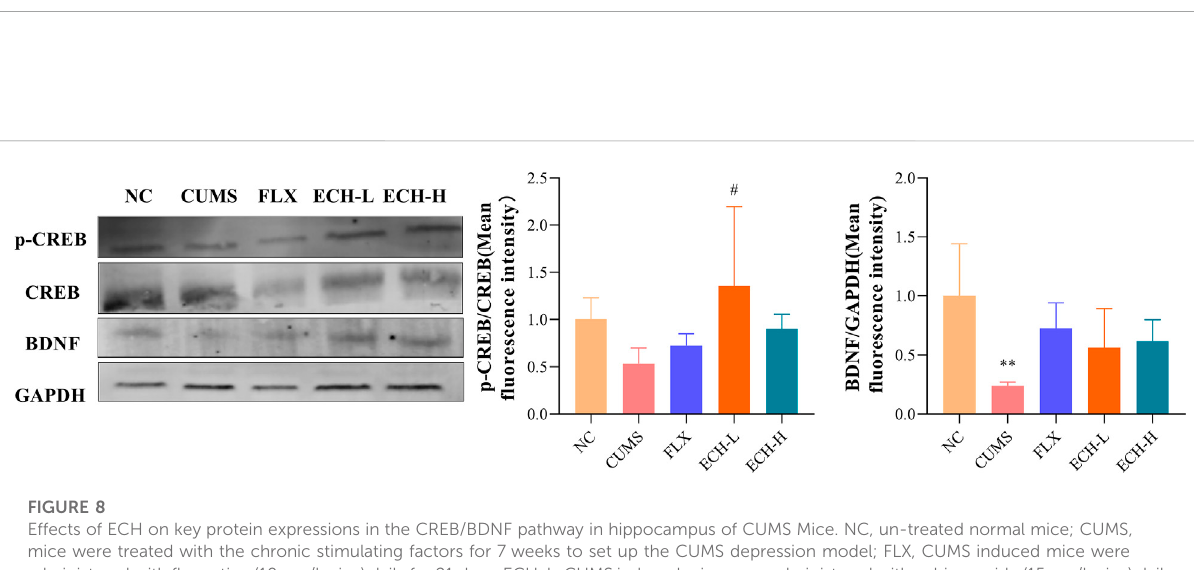
Effects of ECH on p-JAK1/JAK1 and p-STAT3/STAT3 levels in the hippocampus of CUMS Mice. NC, un-treated normal mice; CUMS, mice were treated with the chronic stimulating factors for 7 weeks to set up the CUMS depression model; FLX, CUMS induced mice were administered with fl uoxetine (10 mg/kg,i.g.) daily for 21 days; ECH-L, CUMS induced mice were administered with echinacoside (15 mg/kg,i.g.) daily for 21 days; ECH- H, CUMS induced mice were administered with echinacoside (60 mg/kg,i.g.) daily for 21 days n = 3/group. ** p < .01 compared with control group; # p < .05, ## p < .01 compared with CUMS group.